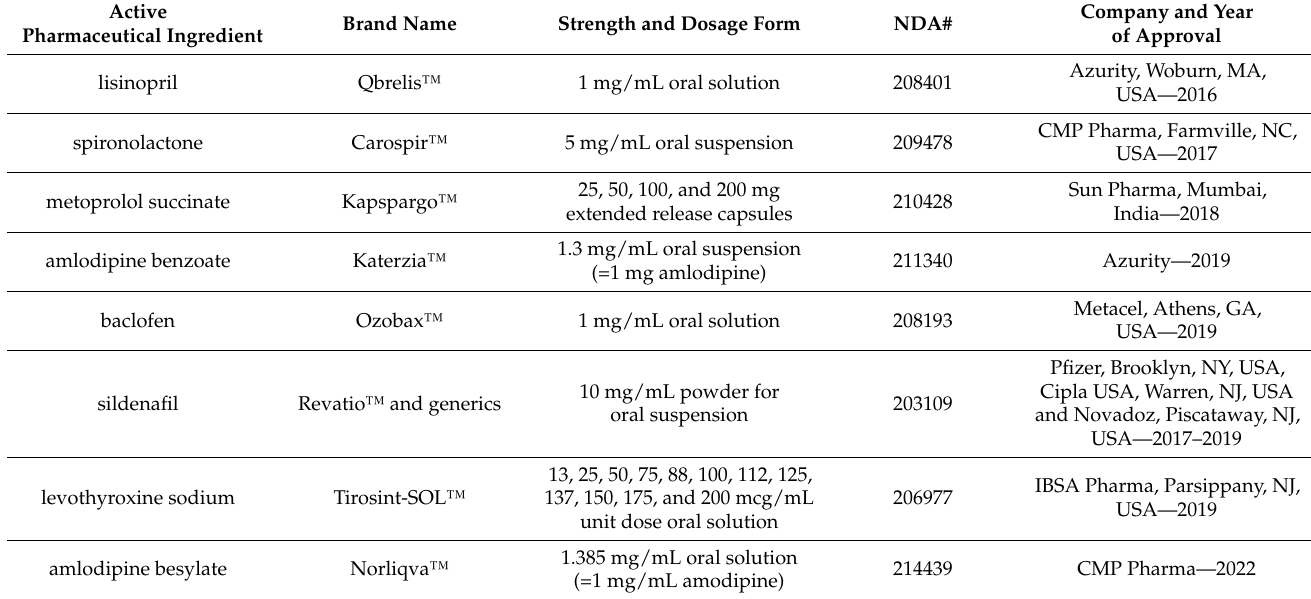
Table 1. FDA-approved commercially available finished liquid dosage forms from the 2016 AA